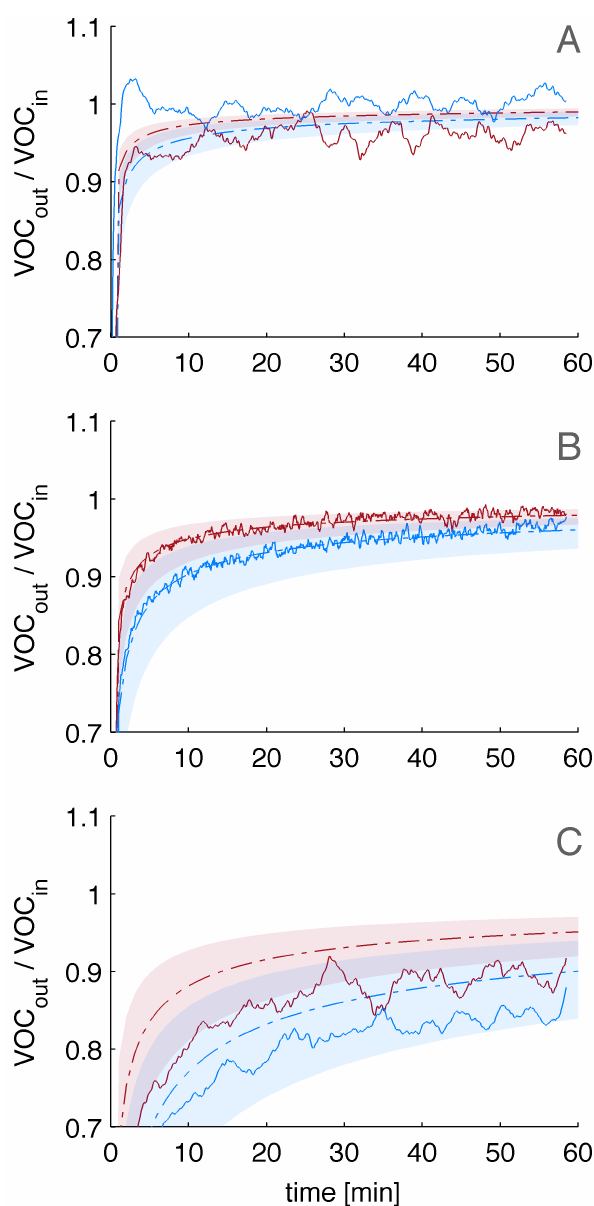
Fig. 2. Mean experimental recovery profiles (solid lines) of methanol (blue) and acetone (red) at different temperatures ( (A) 263K ( n = 3), (B) 243K ( n = 2), (C) 223K ( n = 3)) in packed snow-maker snow. Also shown are results from numerical simula- tions of the recovery (dashed line) with uncertainties (shaded area), where the air–ice partitioning (Langmuir coefficient) was used to parameterize the effective